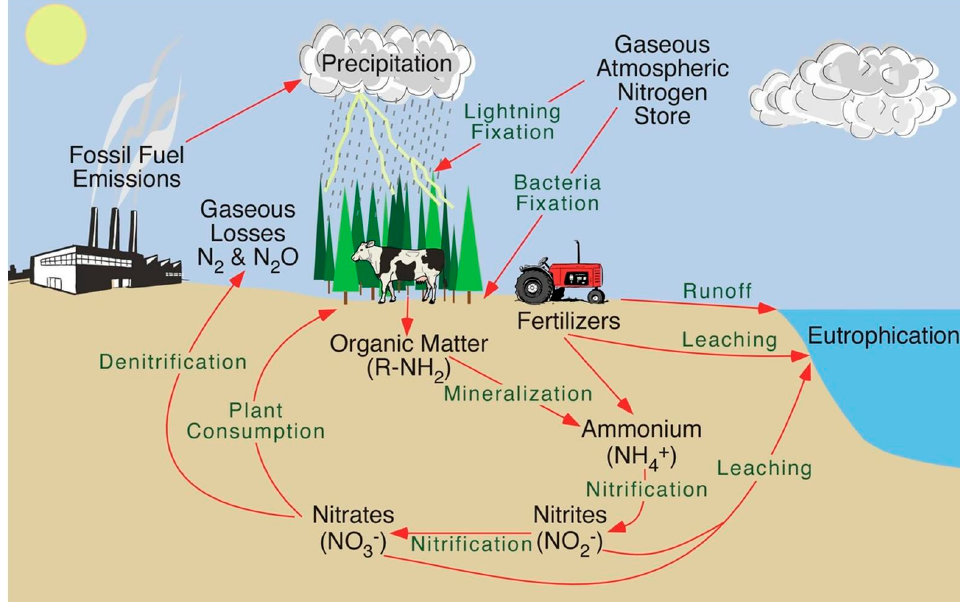
Figure 1. Influence of natural and human activities on the biogeochemical cycle of nitrogen (Used with permission from [38]).